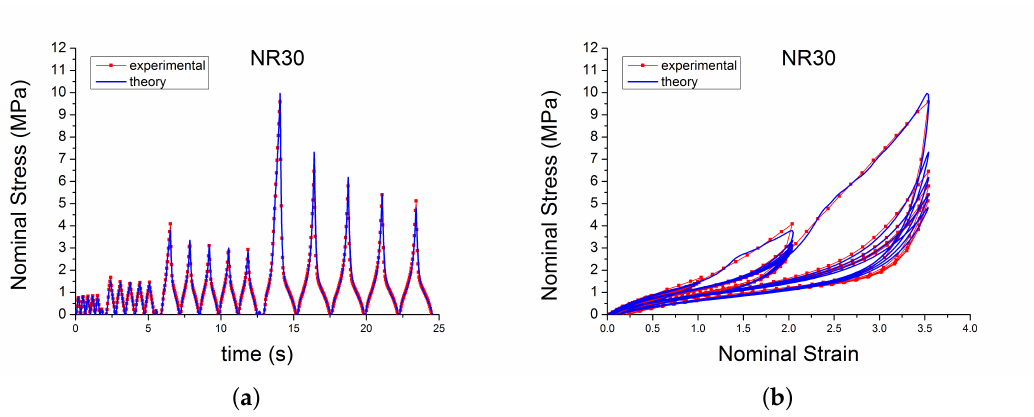
Figure 9. Comparison of the new model with experimental data for NR30 loaded with cyclic uniaxial stress with different maximum strain amplitude in step up. Subfigure ( a ) shows the Nominal Stress versus time. Subfigure ( b ) shows the Nominal Stress versus Nominal